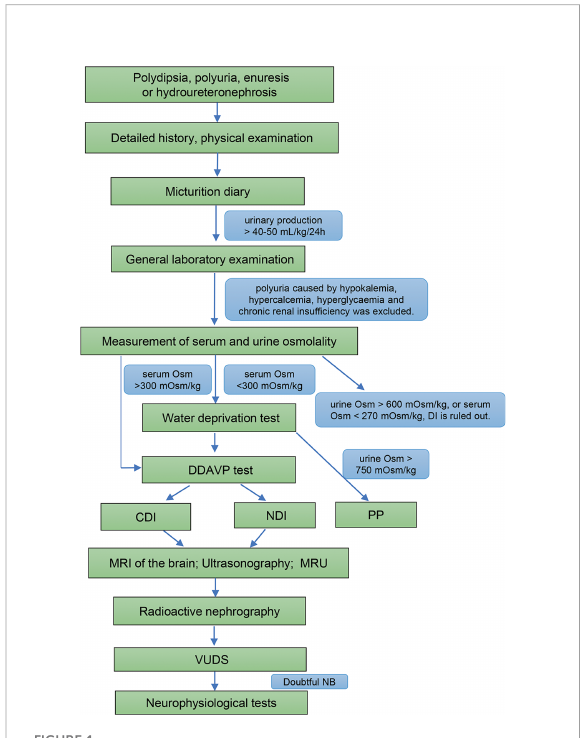
FIGURE 1 Diagnostic fl owchart for DI and DI with NB. Osm, osmolality; DDAVP test, desamino-D-arginine vasopressin test; DI, diabetes insipidus; CDI, central diabetes insipidus; NDI, nephrogenic diabetes insipidus; PP, primary polydipsia; MRI, magnetic resonance imaging; MRU, magnetic resonance urography; VUDS, video-urodynamic recordings; NB, neurogenic